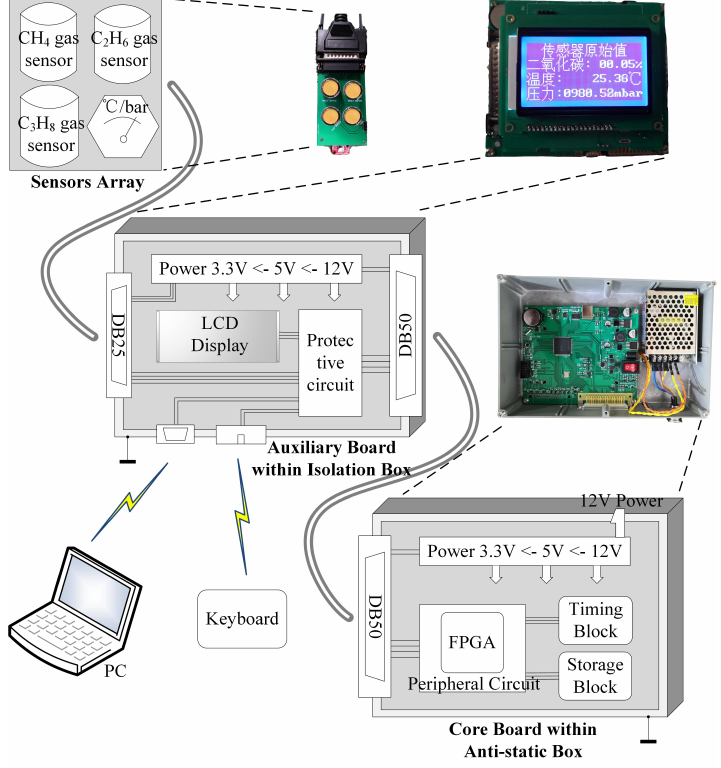
Figure 1. Schematic Diagram of Mixed Natural Gas Monitoring